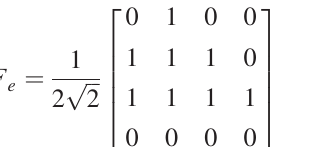
FIG. 6. Numerical simulation for the QHED algorithm. (a) Input 256 × 256 image. (b) Output image encoding the edge informa- tion. The pixels in white and black have amplitude values 0 and 1, respectively.